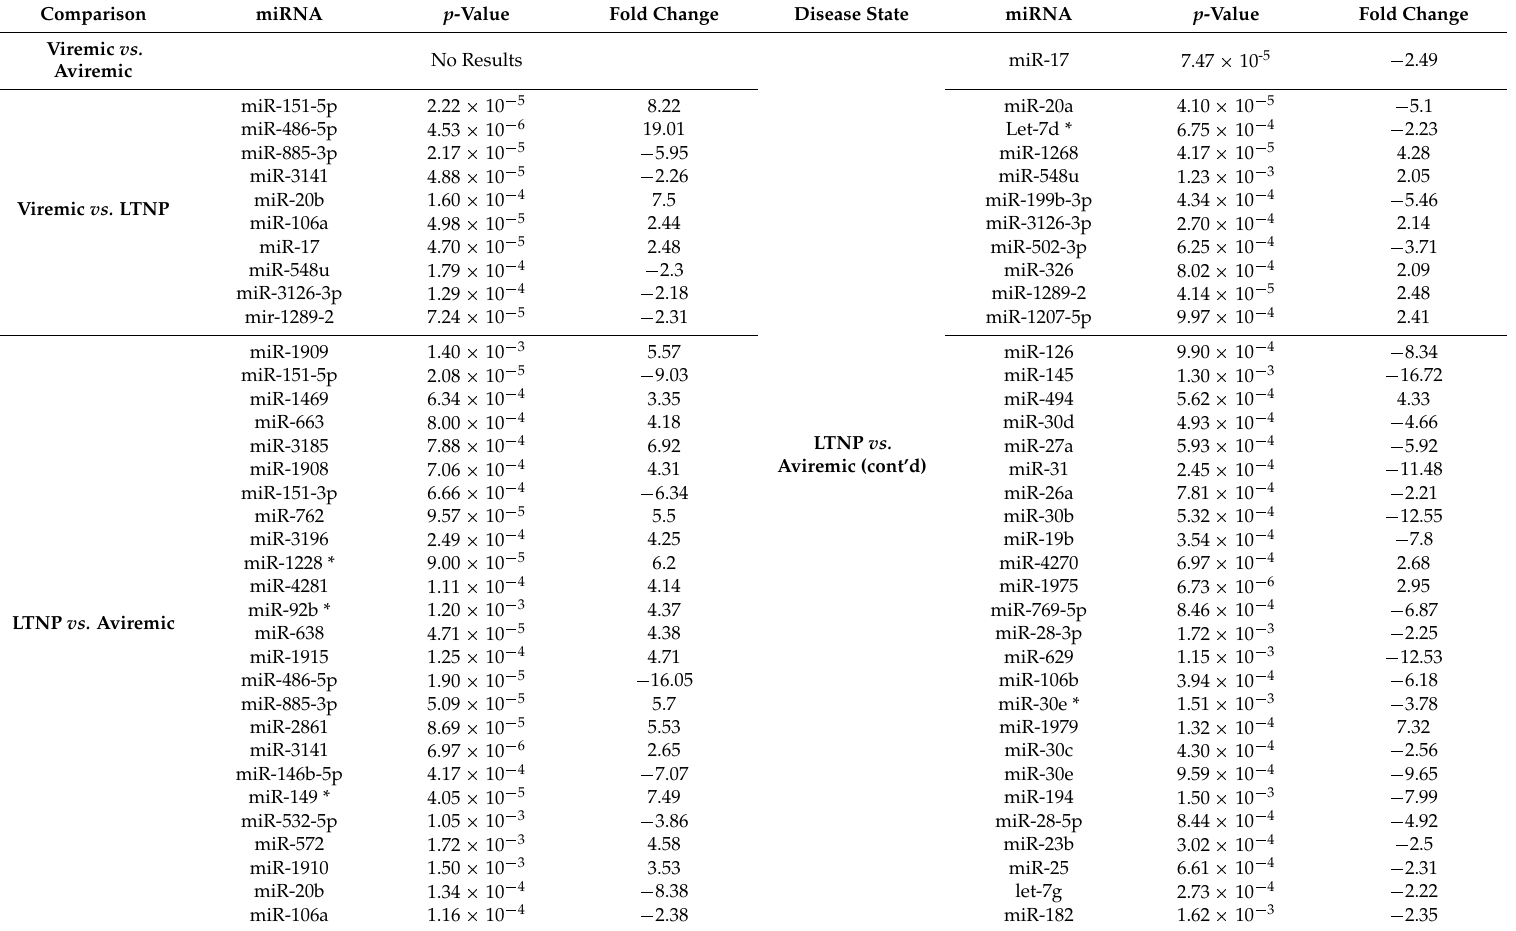
Table 6. DE miRNAs in CD8+ T-cells when disease groups are